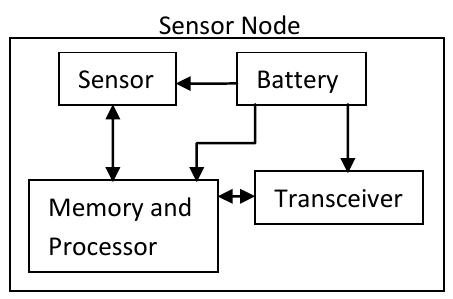
Fig. 1. Typical Sensor Node 4